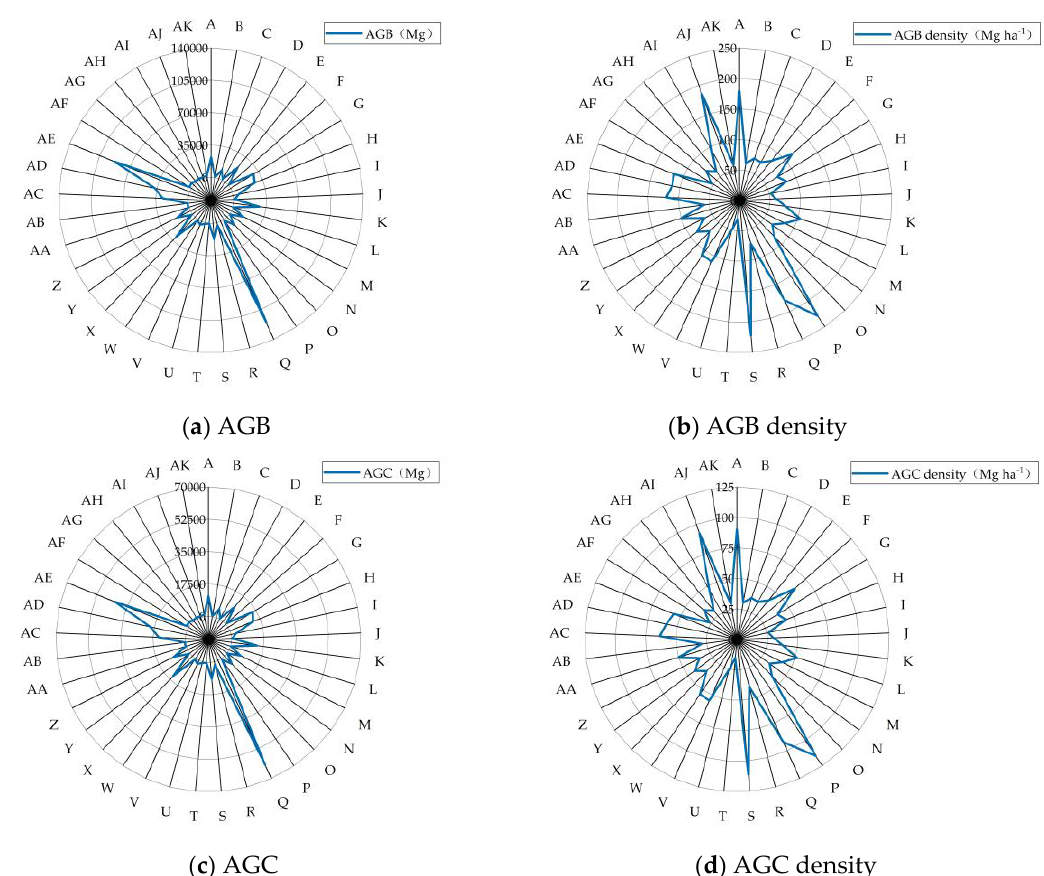
Figure 3. Quantitative differences among forest types. ( a – d ) show radar charts of aboveground biomass (AGB), AGB density, aboveground carbon (AGC) and AGC density, respectively, for A : Abies fabri (Mast.) Craib, B: Abrus spp., C: Betula spp., D: Betula Costata Trautv, E: Betula platyphylla Suk . , F: